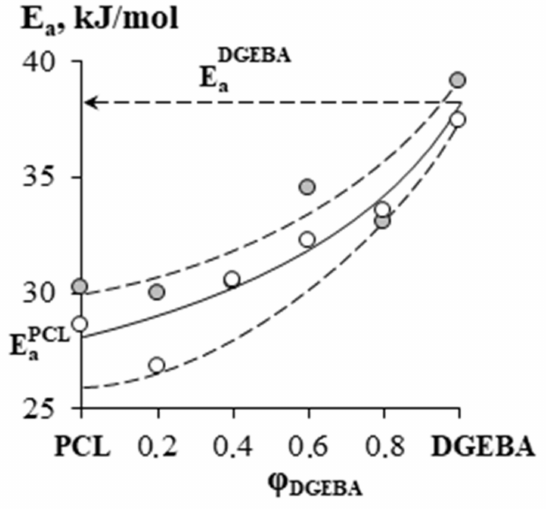
Figure 14. The concentration dependence of the apparent activation energy of interdiffusion in the PCL–DGEBA system, where: —PCL with M n = 45 × 10 3 , —PCL with M n = 80 × 10 3